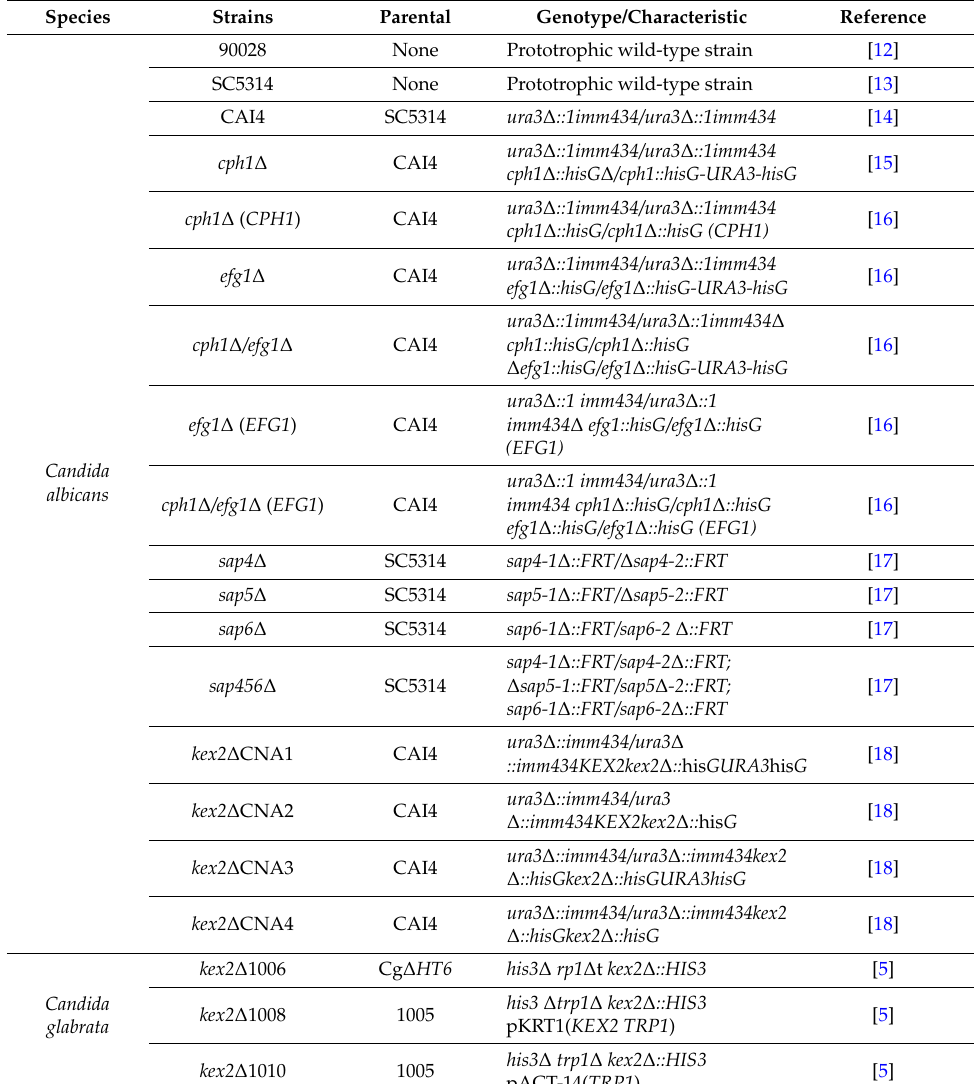
Table 1. The strains used in this study.